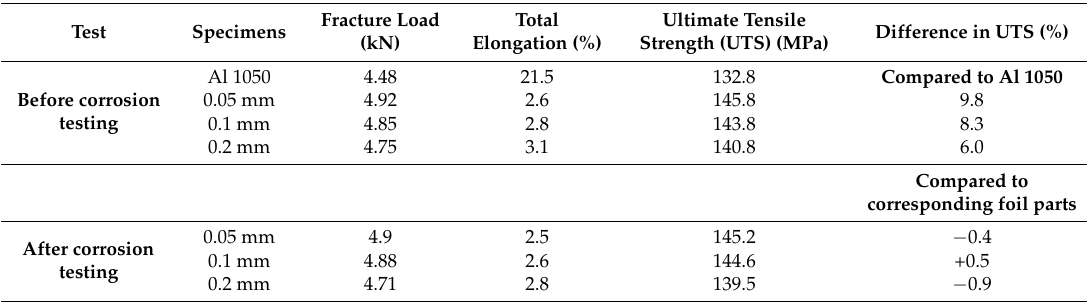
Table 2. Comparative tensile test results before and after corrosion testing.